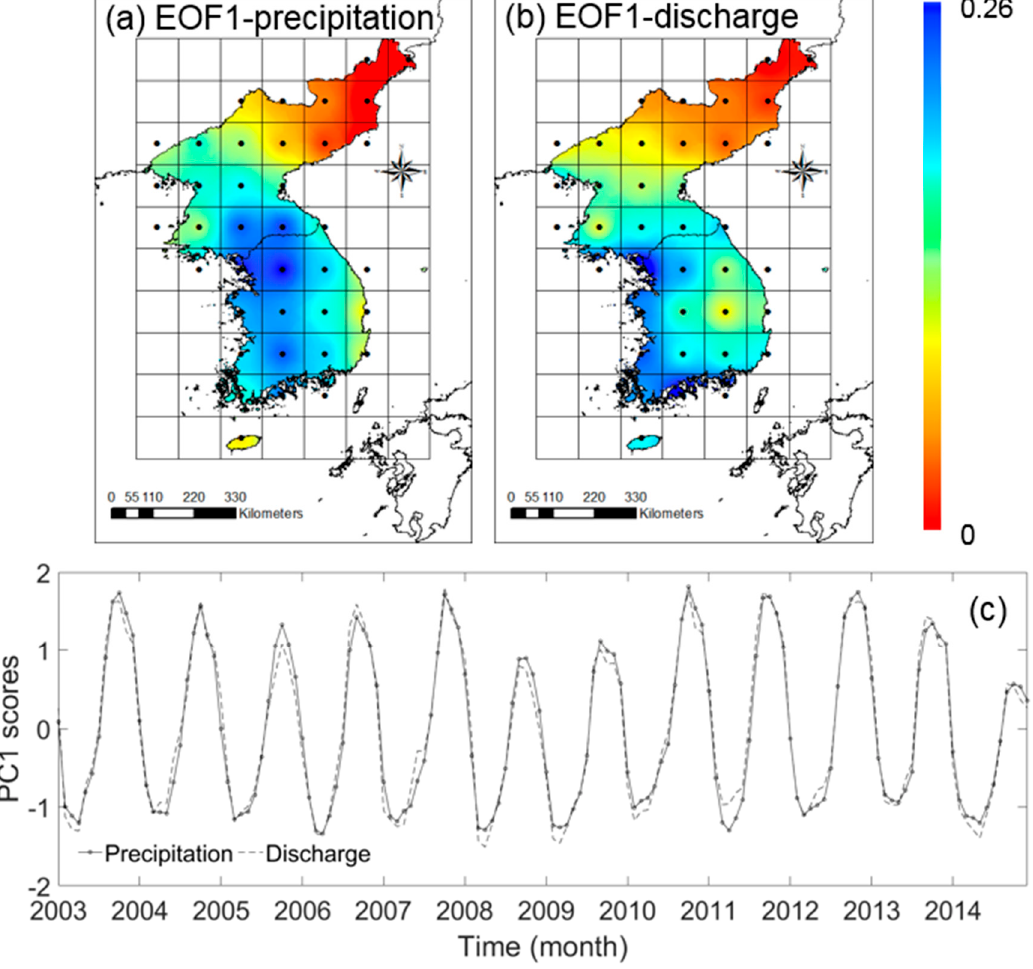
Figure 7. ( a ) Precipitation EOF-1 (variance = 85.2%); ( b ) Discharge EOF-1 (variance = 73.8%); ( c ) Score time series for principal component (PC)1 of monthly precipitation and discharge, 2003–2014.